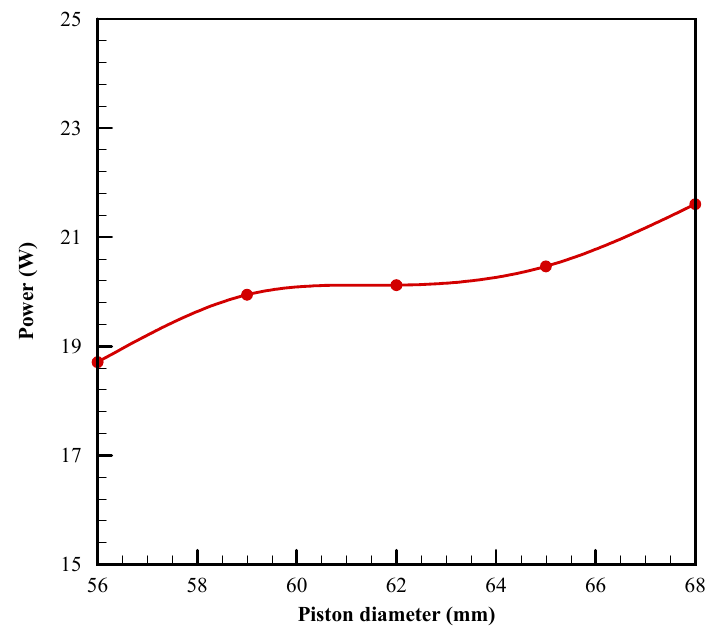
Figure 9. Variation of the engine power with the piston diameter.